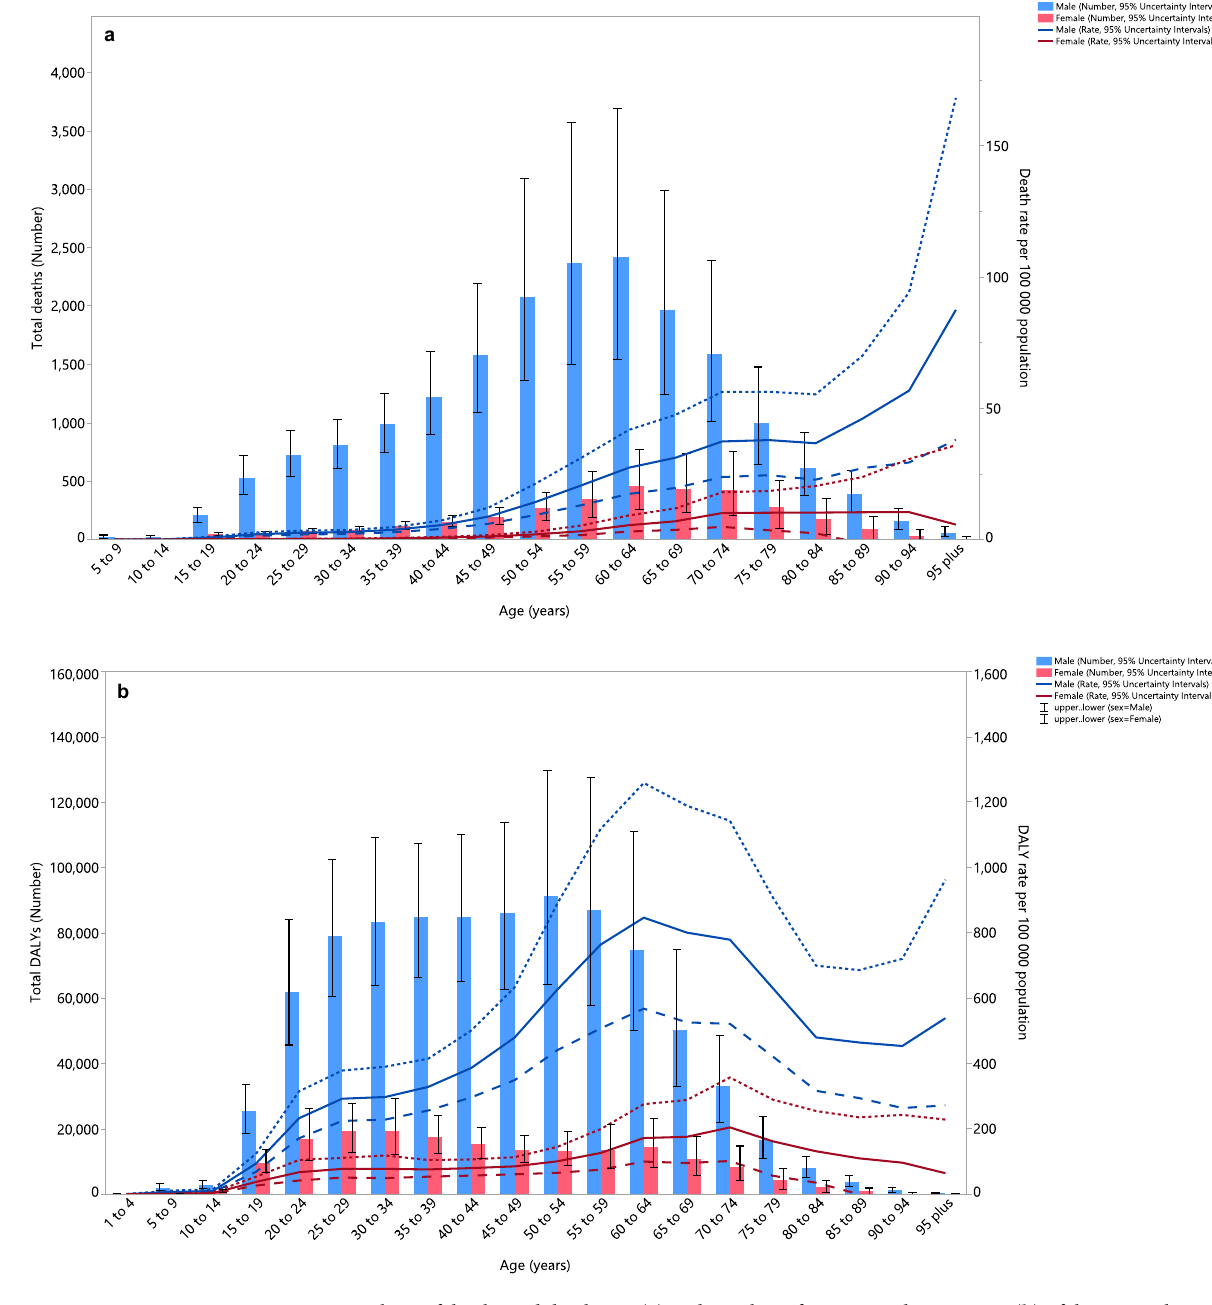
Figure 2. Numbers of deaths and death rate ( a ) and number of DALYs and DALY rate ( b ) of disease and injuries attributable to alcohol consumption in the Middle East and North Africa region, by age and sex in 2019. Dotted and dashed lines indicate 95% upper and lower uncertainty intervals, respectively (Generated from data available from http:// ghdx. healt hdata. org/ gbd- resul ts-